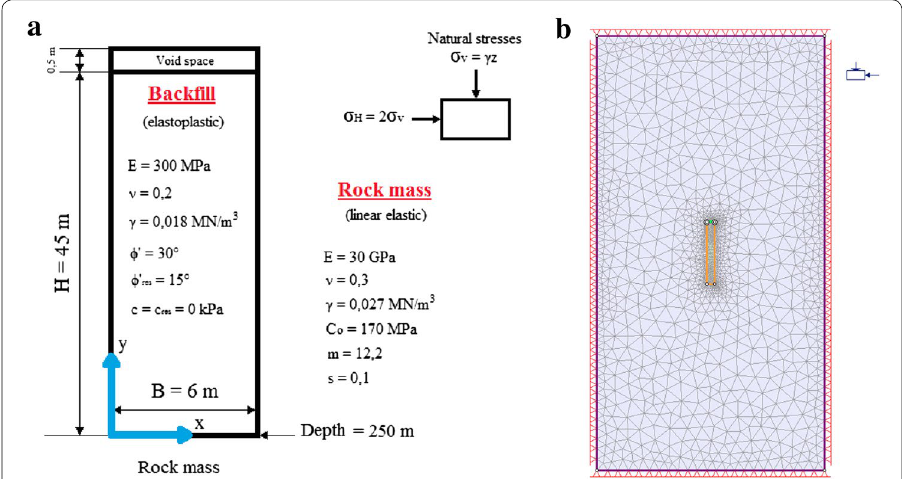
Fig. 3 Geometrical and numerical model and parameters; a vertical stope parameters, with applied stress and mechanical properties of the backfill and the rock mass; b finite element